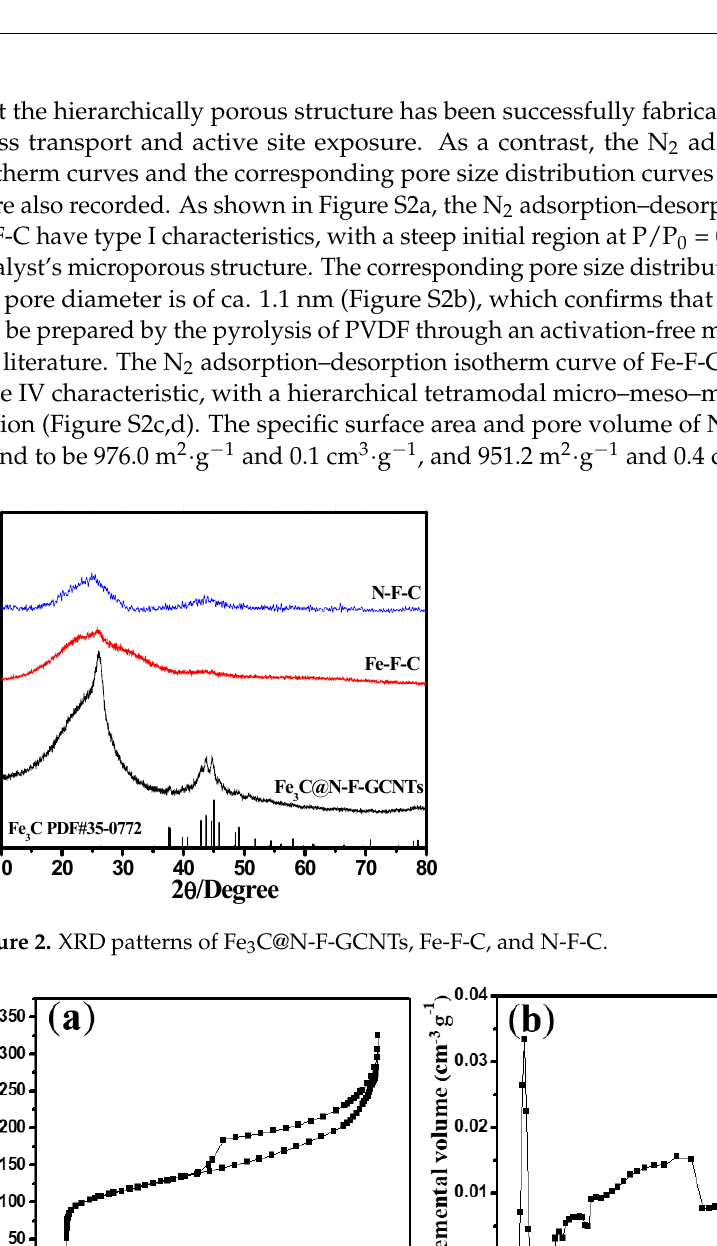
Figure 2. XRD patterns of Fe 3 C@N-F-GCNTs, Fe-F-C, and N-F-C.